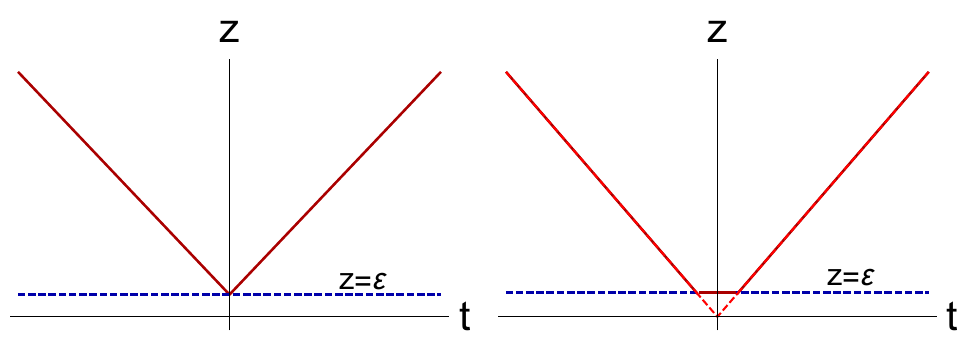
Figure 10 . The di(cid:11)erent WDW patch